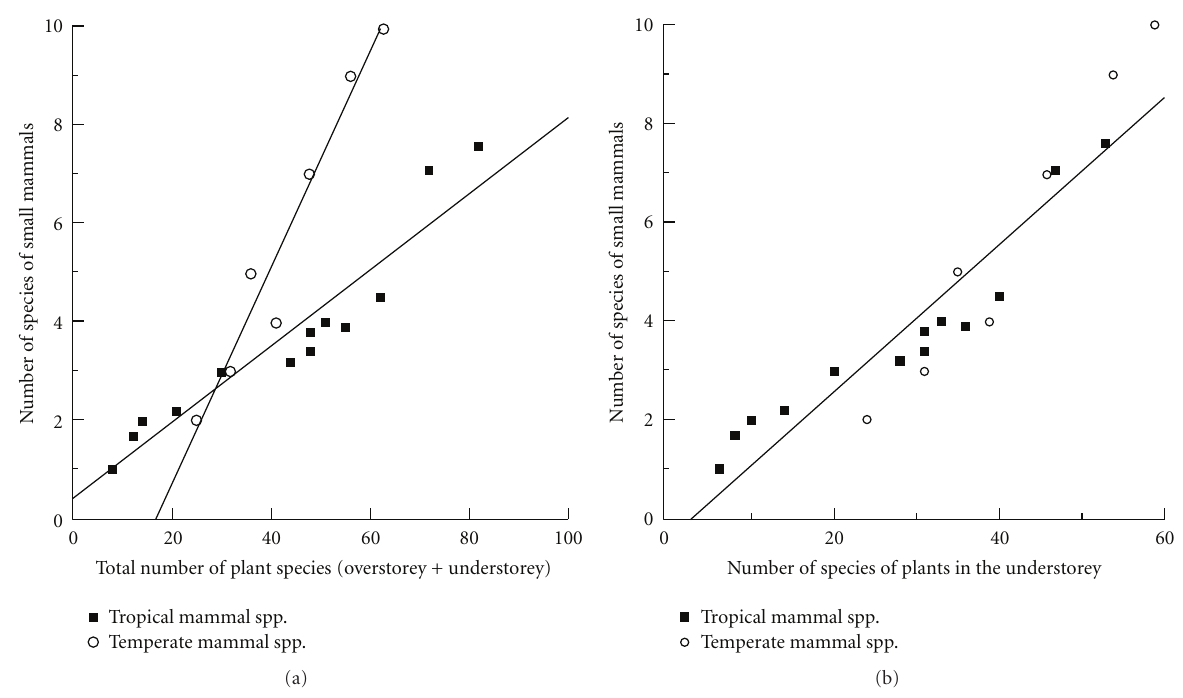
Figure 6: Number of small mammals recorded in plant communities in both southern and northern Australia is linearly correlated with (a) the total number of species of vascular plants in each plant community and (b) the number of plant species in the understorey [5, Figure